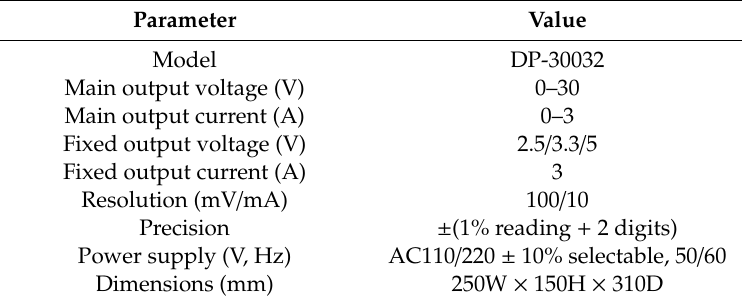
Figure 3. Photographic view of the device set up on ( a ) model A and ( b ) model B of the experimental motorcycle. Table 4. The specification of NTP control device.